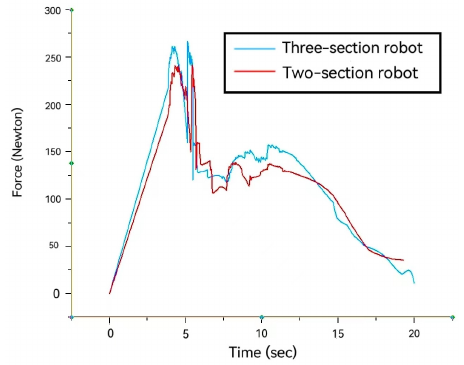
Figure 11 . Movement speed of the pipeline robots with di ff erent numbers of sections.